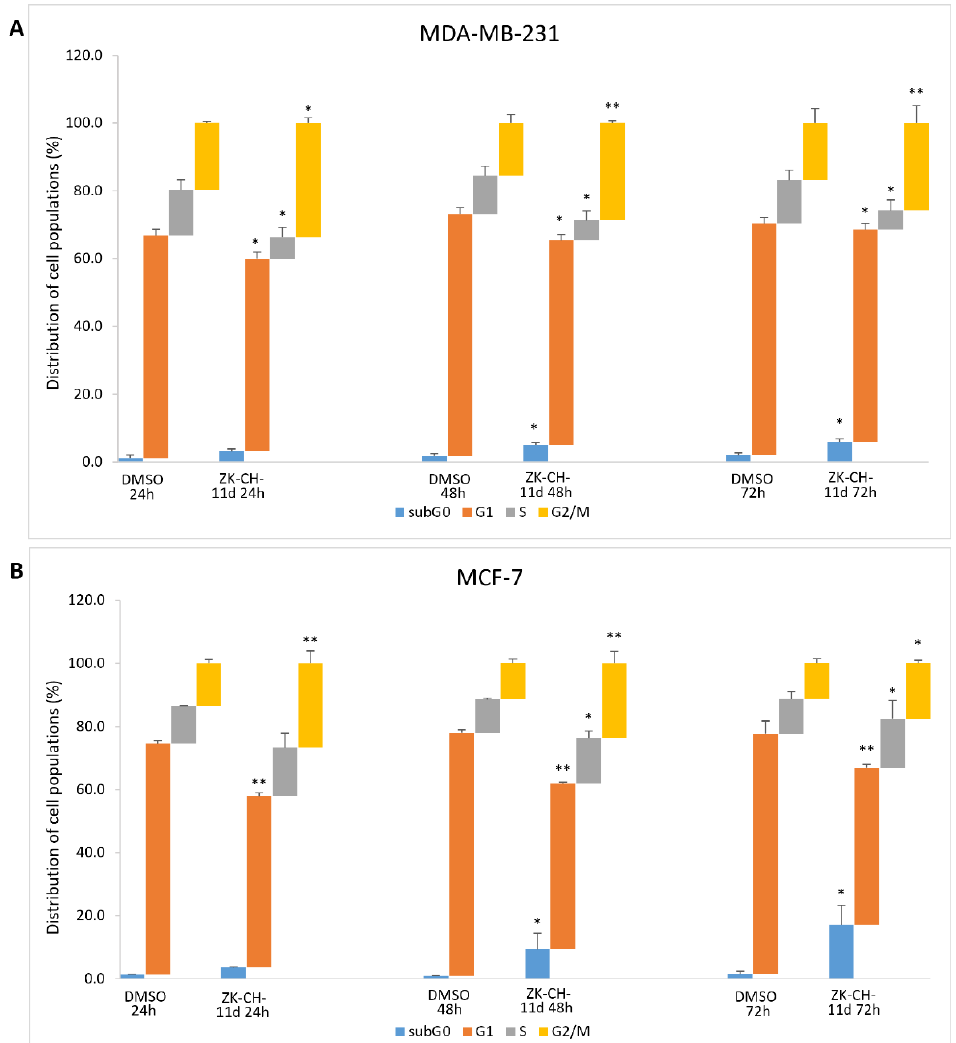
Figure 4. Cell cycle analysis of MDA-MB-231 ( A ) and MCF-7 ( B ) cells after treatment with chalcone ZK-CH-11d 24, 48, and 72 h at a concentration of 40 μmol /L. Values show the mean of three independent experiments. Statistical significance: * p < 0.05, ** p < 0.01 vs. DMSO (vehicle).